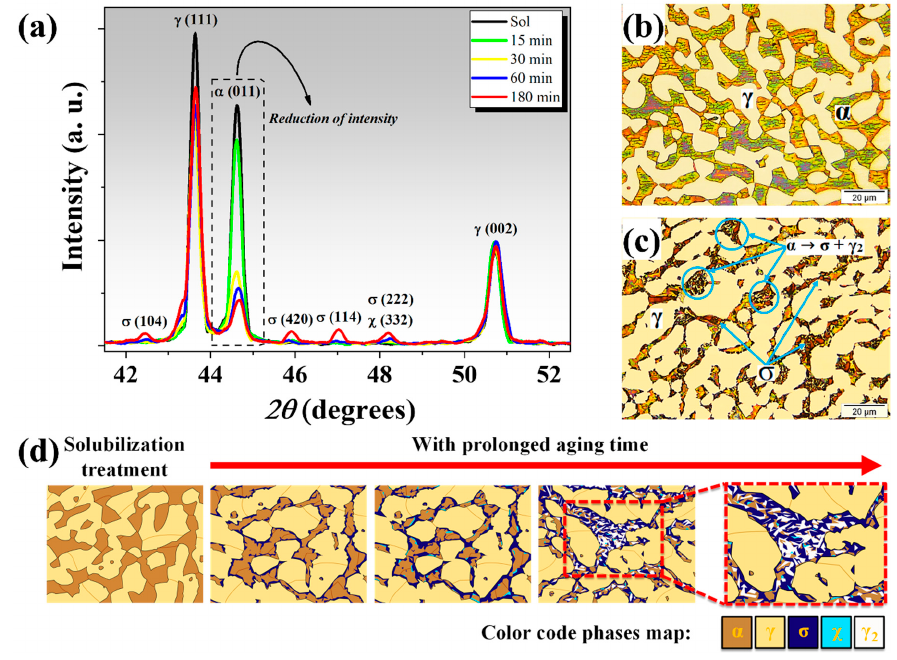
Figure 2. ( a ) XRD patterns, ( b , c ) OM of the specimens (0 and 180 min of aging, respectively), and ( d